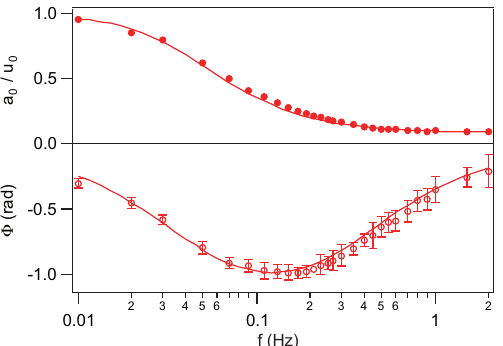
Figure 14. Rheological curves and their global fit with Equation (23) for a 100 µ m-thick sample of 8CB at 32 ◦ C when α = 5 × 10 − 4 rad and u 0 = 100 nm. The error bars for the ratio a 0 / u 0 are very small, of the order of the size of the filled circles (adapted from Ref. [55], with kind permission of the European Physical